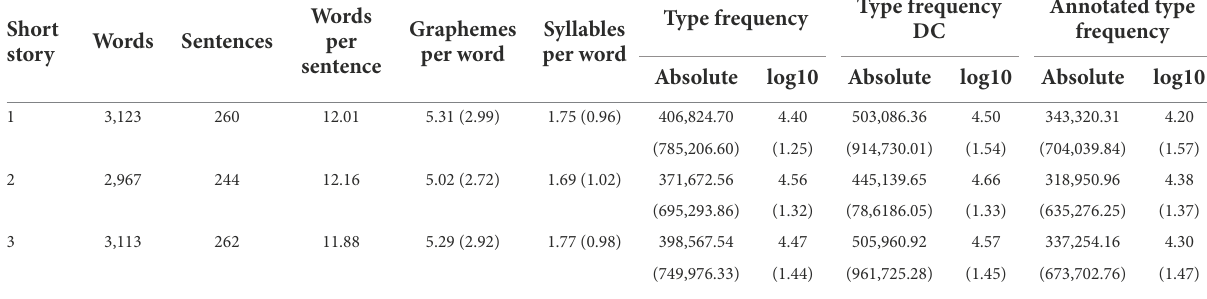
TABLE 2 Key characteristics per